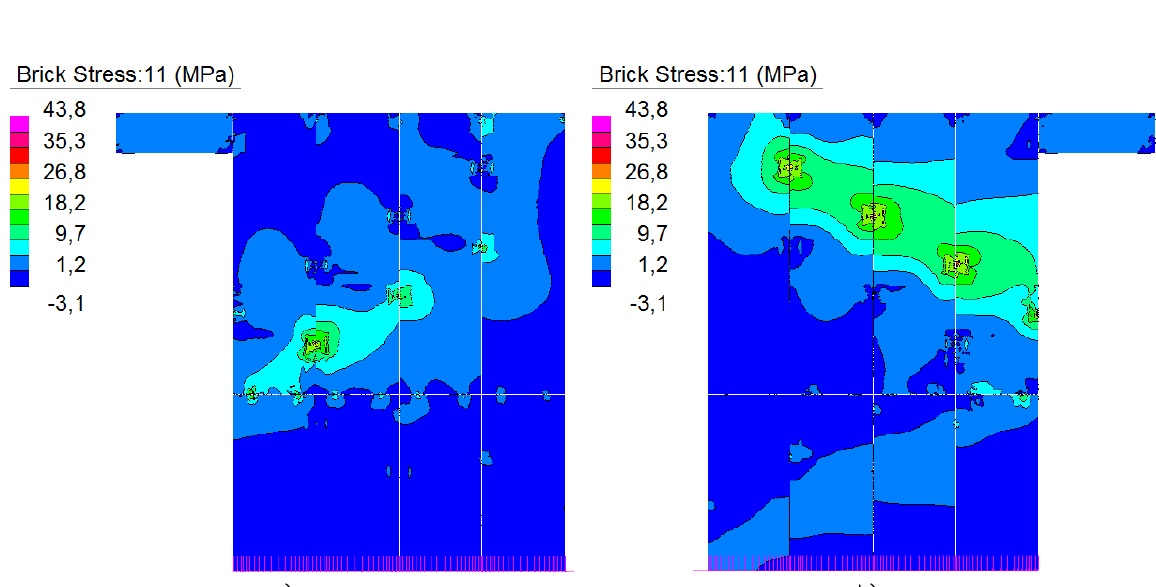
Fig. 15 Principal tensile stresses in the glass layers of the central laminated glazing – load combination ULS n.2, a) front view, b) back